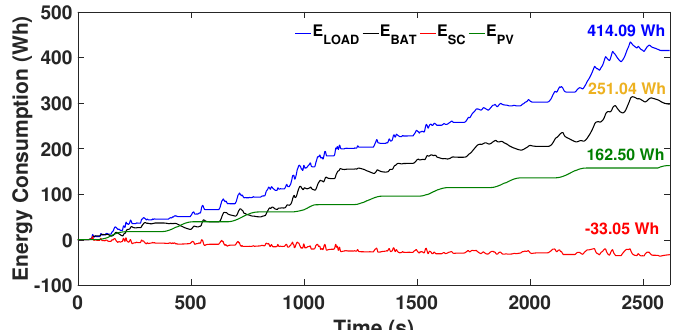
Figure 12. Comparison of source energy consumption of IHSEMS under CDP.